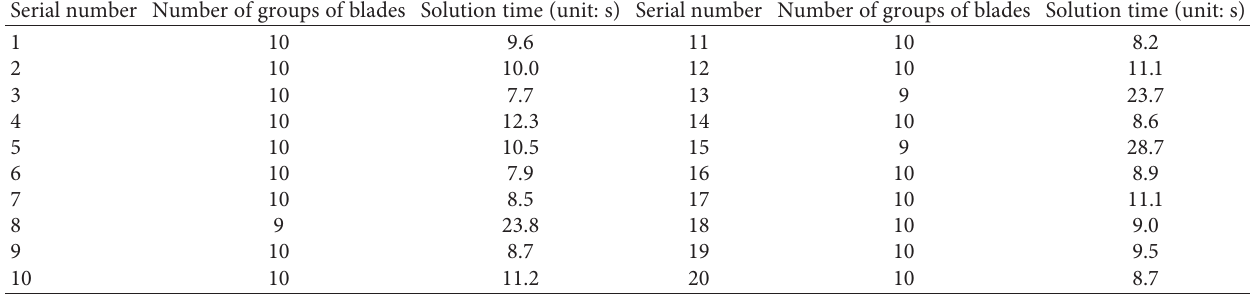
Table 5: Statistic table of solution time and selection results of rotating blades optimization-selection algorithm based on the collocation degree of blades.